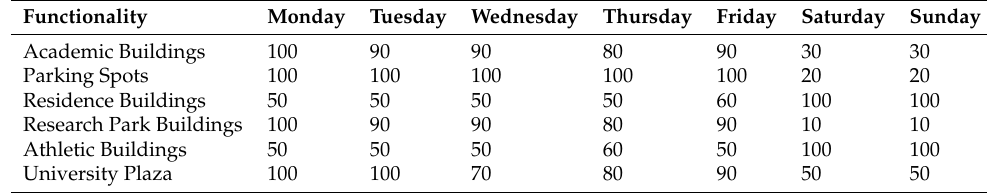
Table 9. The Estimated Utilization Rate for Different Functional Buildings for Each Day over a Week.